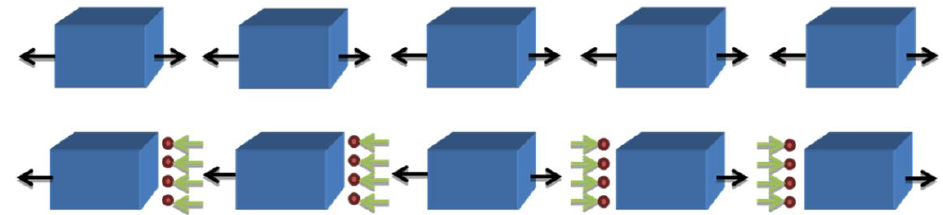
Figure 8. A diagrammatic sketch of the atomic-level stress between the three divided regions in this model. The upper and the lower panels indicate the stress corresponding to the 0% and 4% strains, respectively. The black and celadon arrows stand for the applied stress and atomic-level stress, respectively. Table 3. Atomic percentages of the center, transitional, and marginal regions in the deformed structural models. Note that all of these values are nearly 20% when the strain is zero.